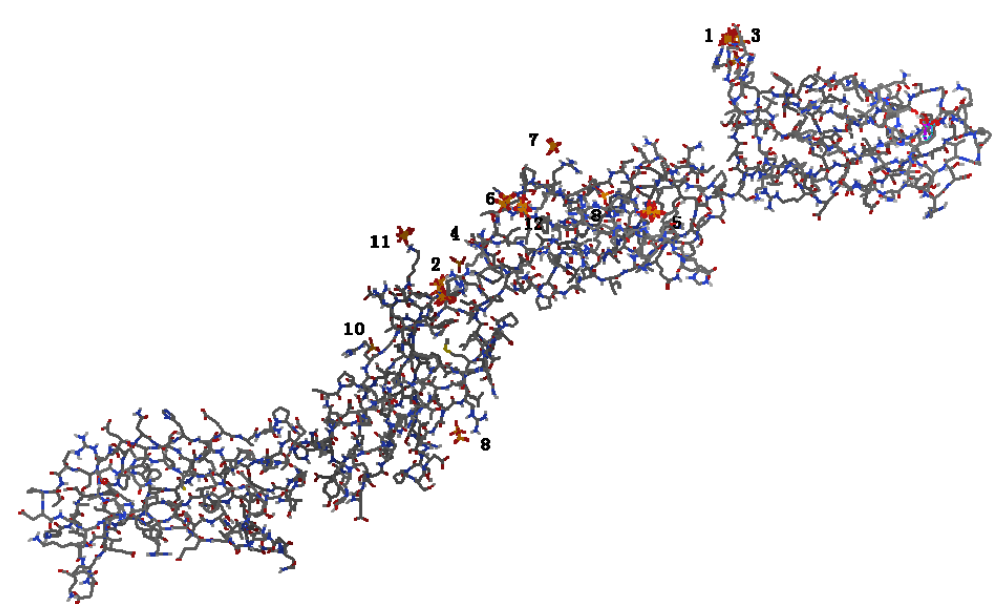
Figure 2. Binding sites on FN surface predicted by AutoDock 4.